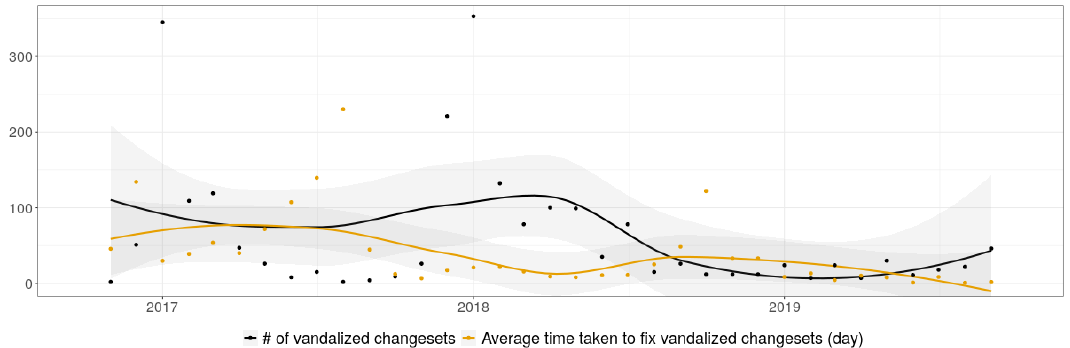
Figure 8. Inverse relationship between the number of vandalized changesets and the average time it took to fix